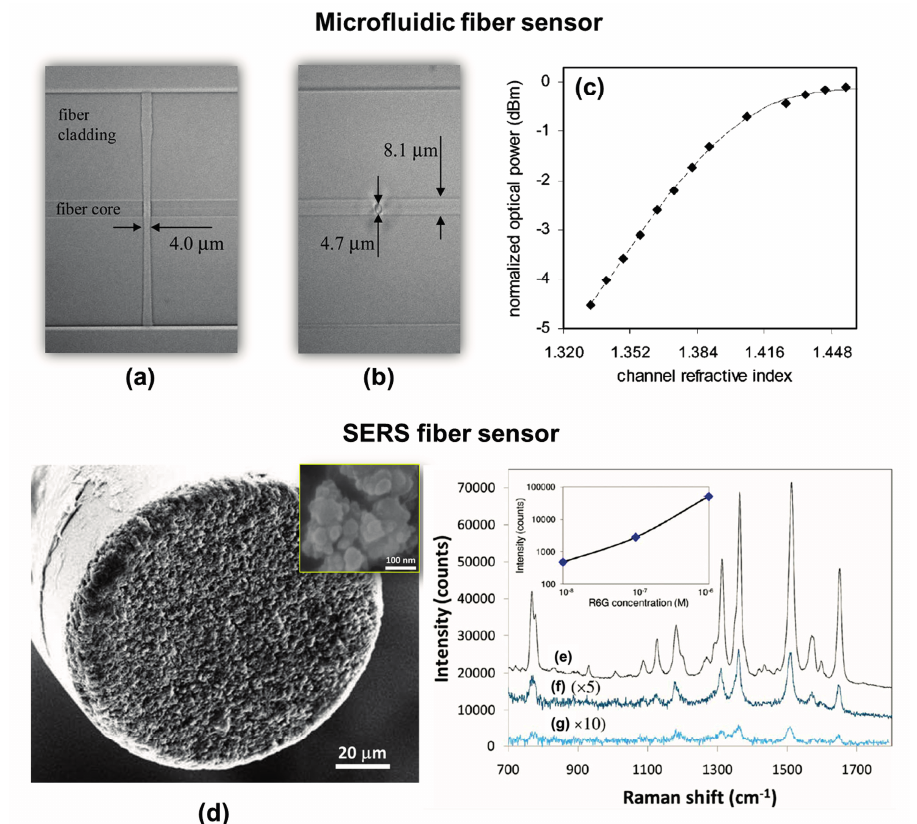
Figure 16. Microfluidic- and surface-enhanced Raman-scattering (SERS)-based